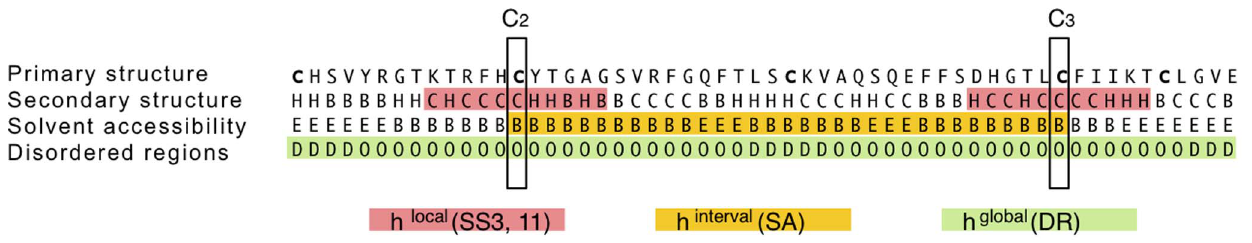
Figure 3. Example of local, interval and global histograms. C 2 and C 3 are the two cysteines of interest. In red, we show the labels local histograms of size 11 of the secondary structure h local ( SS 3,11) . In yellow, we show the labels interval histogram of the solvent accessibility annotation h interval ( SA ) . In green, we show the global histogram of the disordered regions sequence h global ( DR ) .